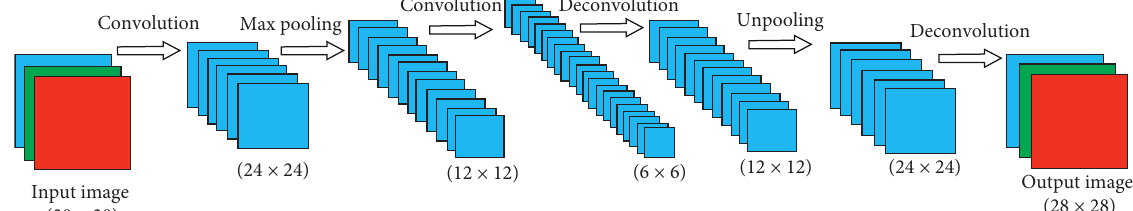
Figure 2: An example of the structure of a 2D CAE.